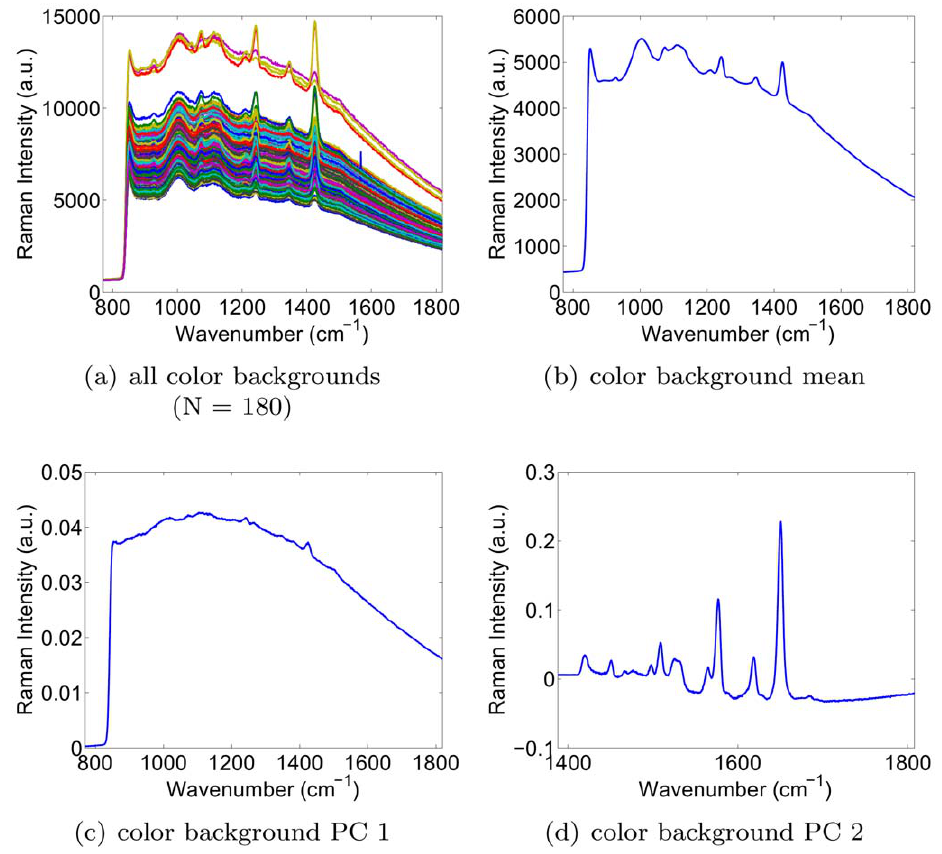
Figure 4. Background signals of the printed colors: mean and first two principal components.